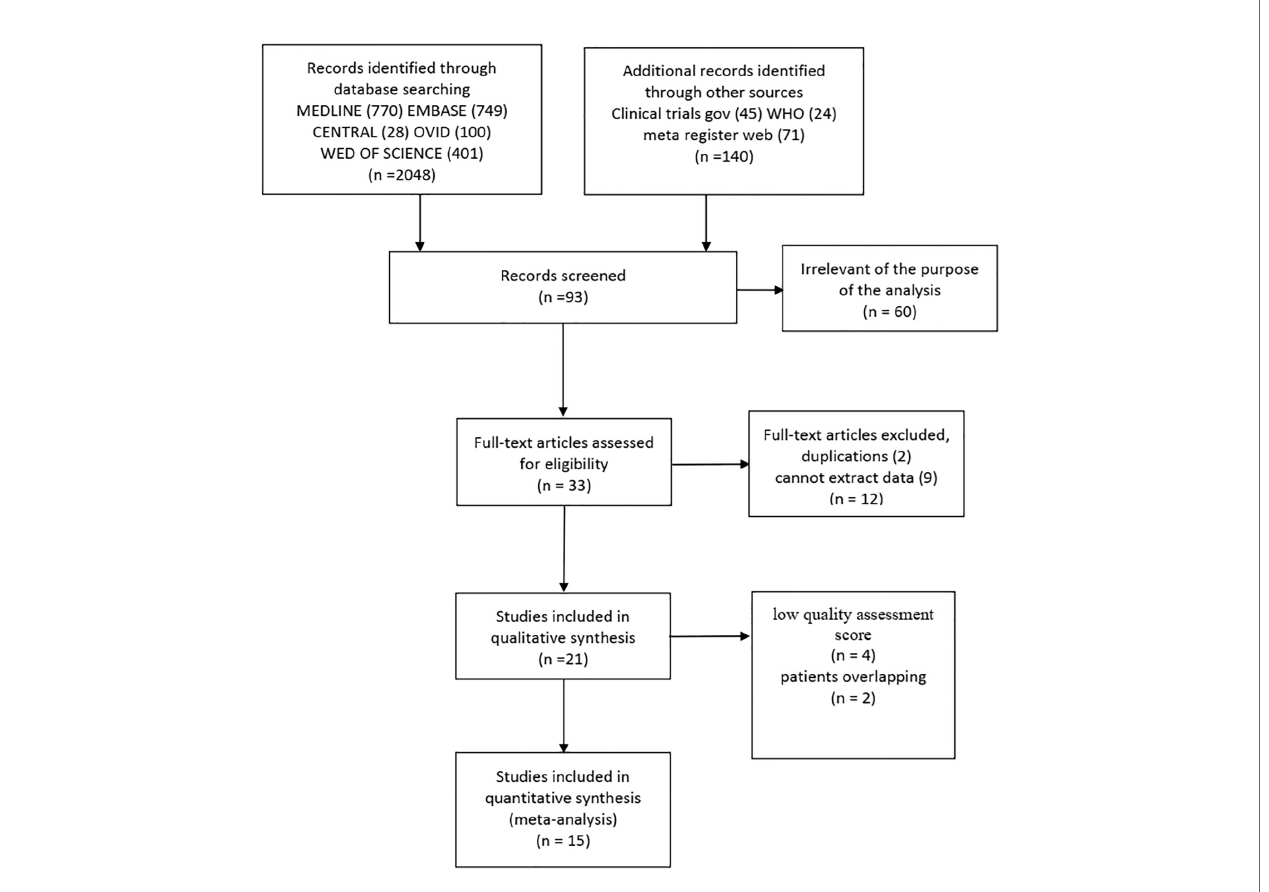
FIGURE 1 | Selection of studies for inclusion in the systematic